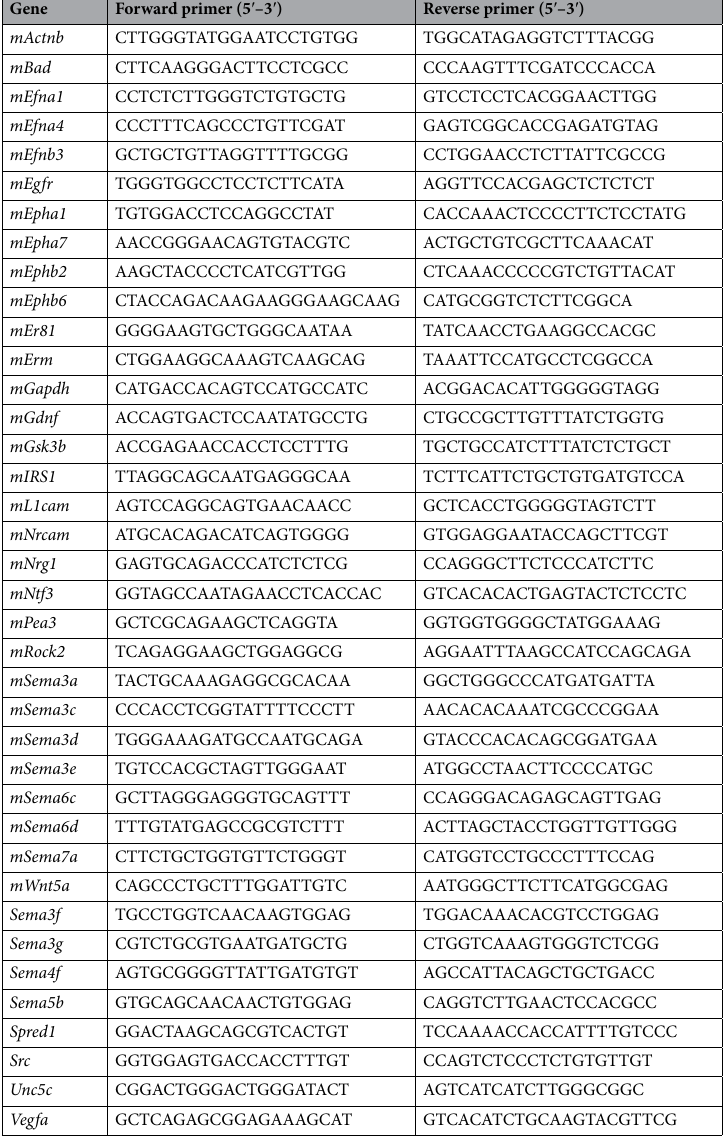
Table 3. The list of primers used in qPCR assays. Primers for human genes, denoted in all capital letters, were used for validation in human SH-SY5Y cells, whereas primers specific for mouse genes, denoted with only first letter capitalized, is used for validation in mouse mHypo-A2/12 and mHippo-E14